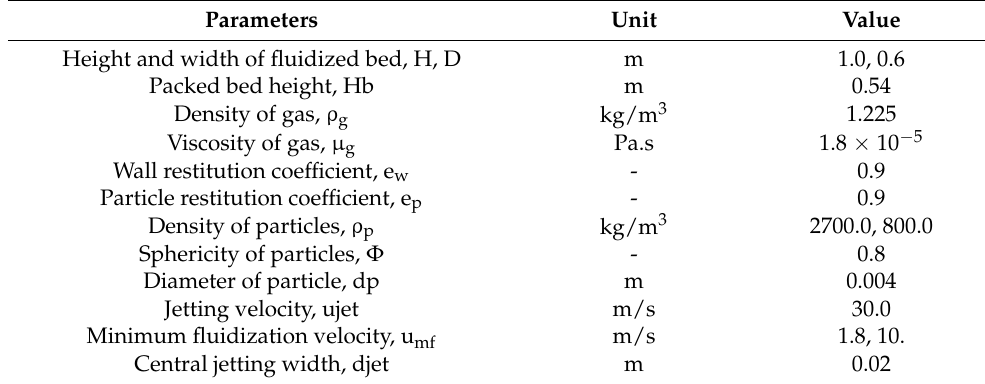
Table 1. Parameters of modeling simulations and experimental measurements.